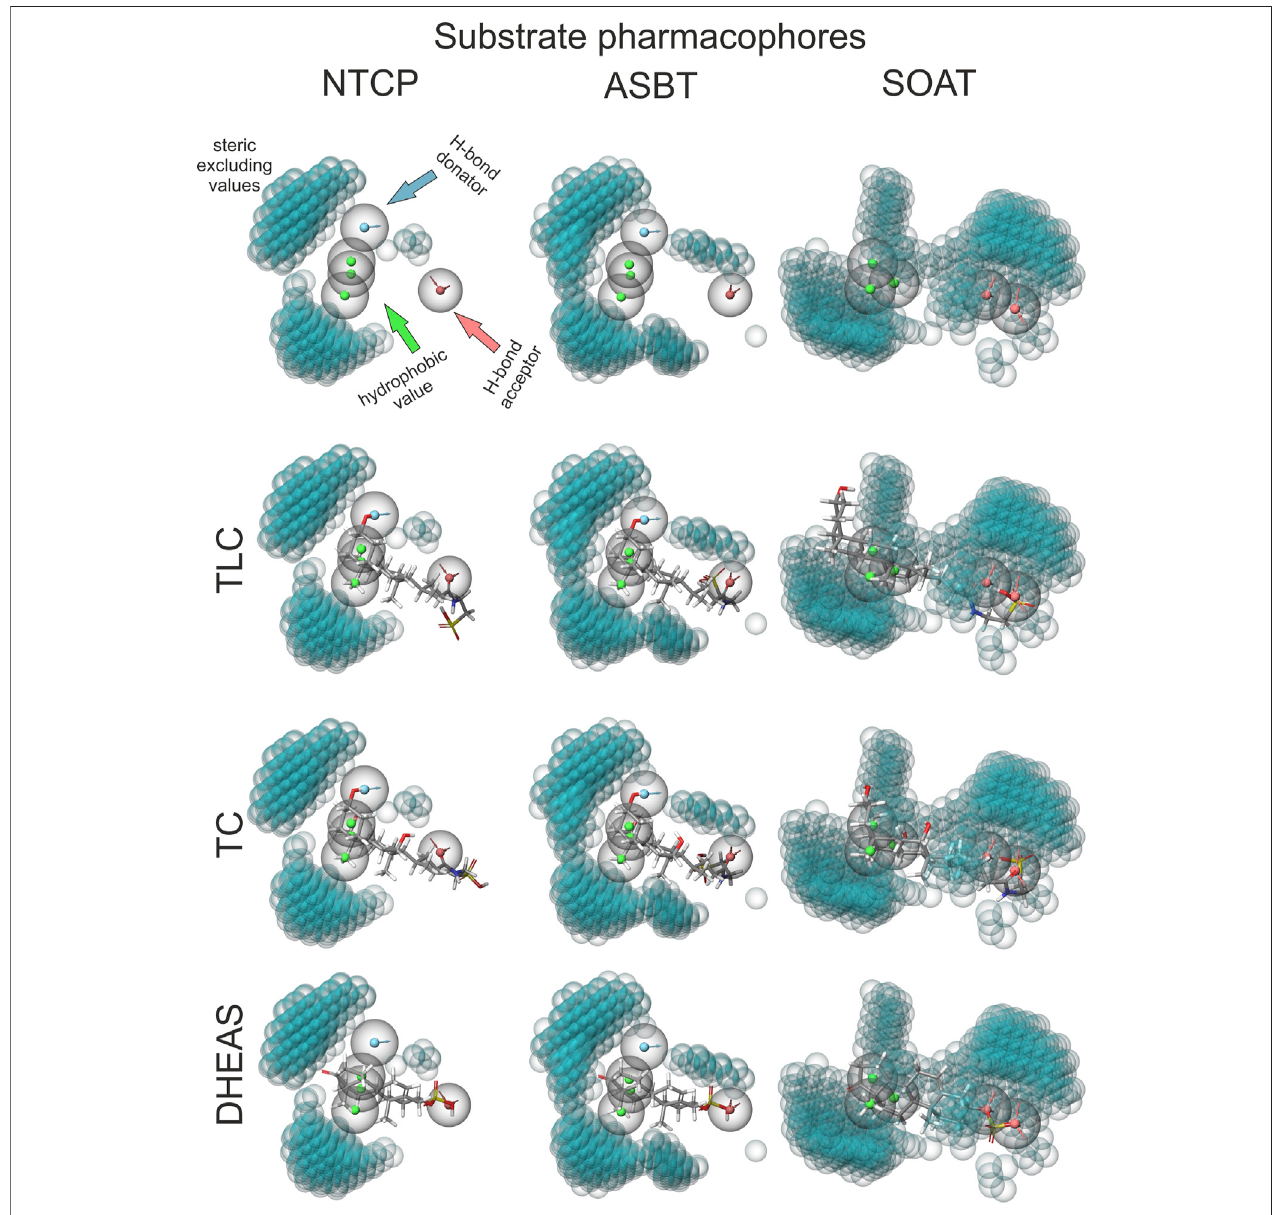
FIGURE 7 | TLC, TC and DHEAS fi tted to substrate pharmacophore models for NTCP, ASBT, and SOAT. Pharmacophore models were generated via the MAESTRO Molecular Modeling Interface (Version 12.2) of SCHRÖDINGER software with all substrates listed in Table 1 . For size comparison: steric excluded volume sphere radii 1 Å (little blue spheres). H-bond donators are depicted as spheres with a blue core and outward facing arrows. H-bond acceptors are depicted as spheres with a red core and inward facing arrows. Hydrophobic values are depicted as spheres with green cores. Top line shows the calculated empty pharmacophores. Lines below show best fi tting of TLC, TC and DHEAS into the respective